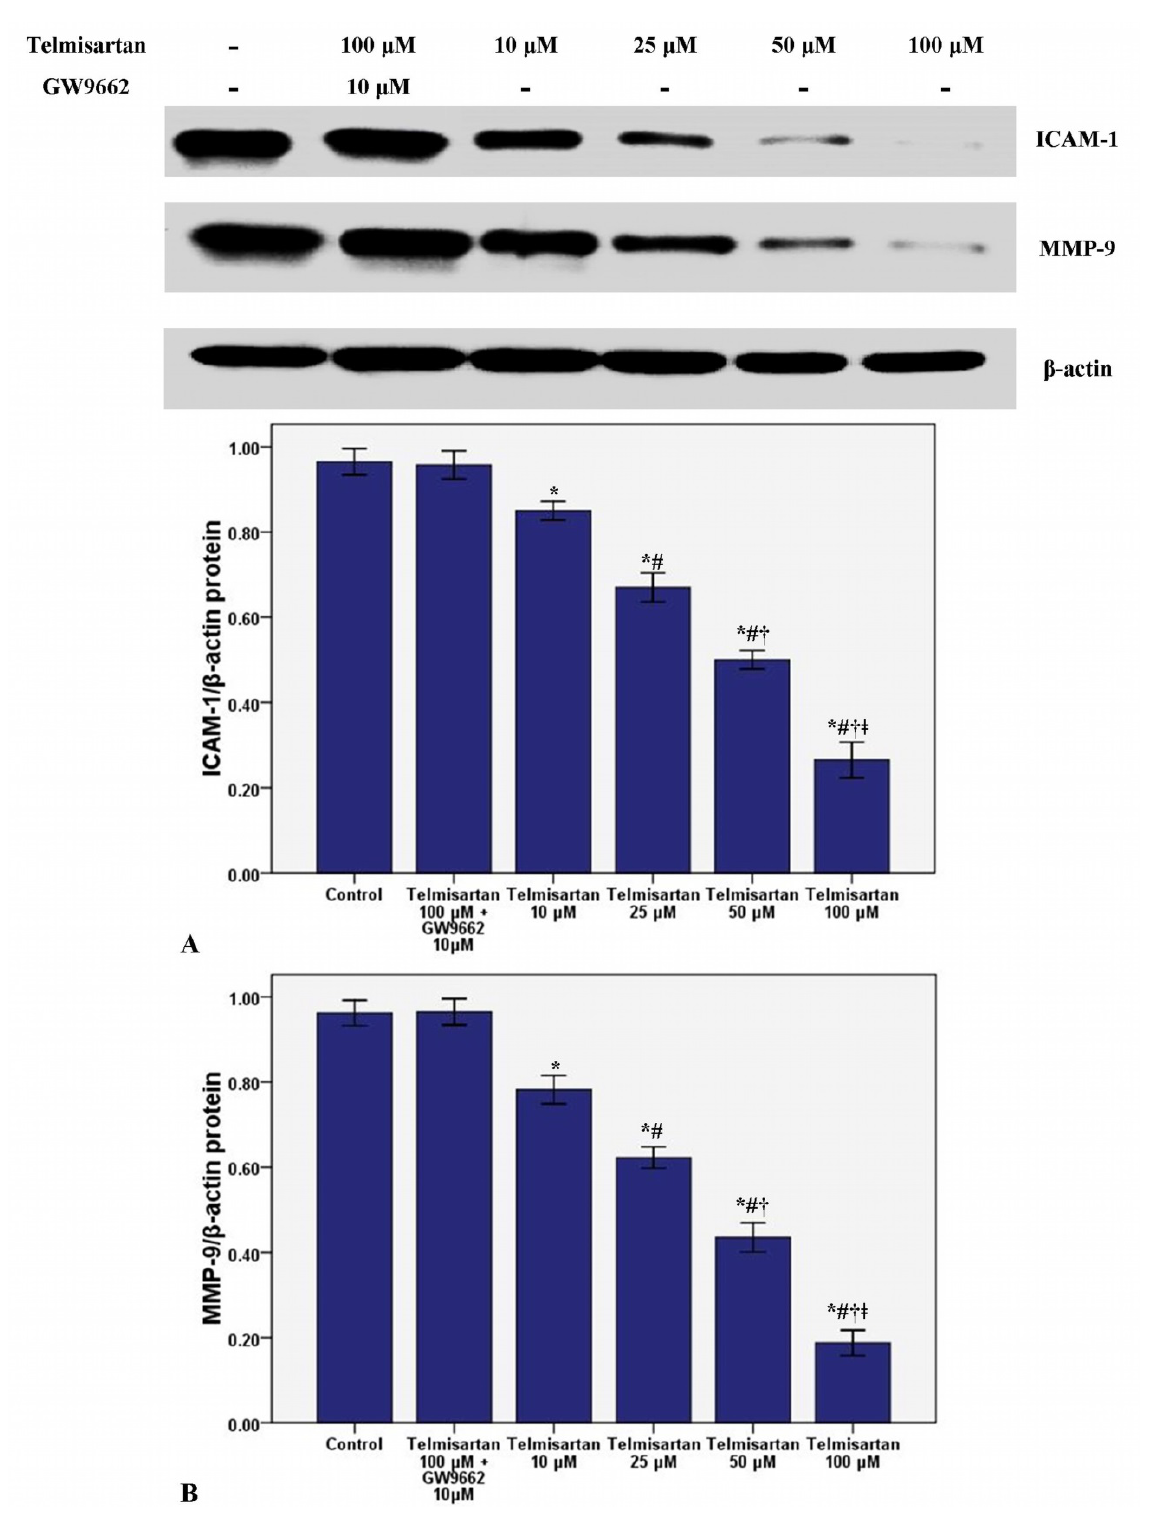
Figure 4. Telmisartan reduces the protein expression of ICAM-1 and MMP-9 in A549 cells. The protein expression of ICAM-1 ( A ) and MMP-9 ( B ) in A549 cells treated with 4 concentrations of telmisartan (10, 25, 50 and 100 μ M) or GW9662 (10 μ M) for 48 h were measured. Quantitative data were presented as mean ± SD ( n = 4). * p < 0.05 compared with Control. # p < 0.05 compared with 10 μ M telmisartan. † p < 0.05 compared with 25 μ M telmisartan. ǂ p < 0.05 compared with 50 μ M